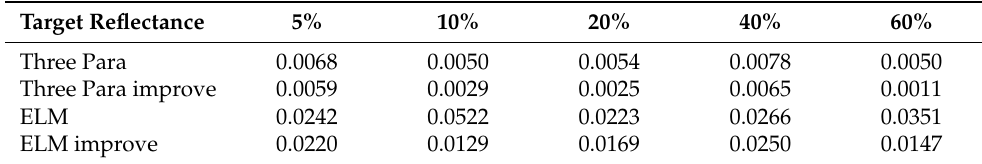
Figure 9. The absolute error between the retrieved results of multi-gray level target and in suit measurement results: ( a ) ELM method; and ( b ) ELM method of adding illumination correction. Table 2. Mean absolute error of different calibration